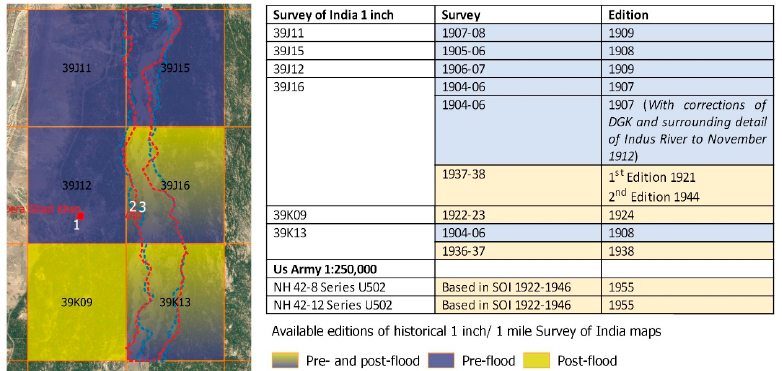
Figure 5. Editions of the SoI 1” to 1-mile maps used for this study and its geographical and temporal coverage. The whole area is also covered by two maps from the US Army Map Service, Series U502 (1955).